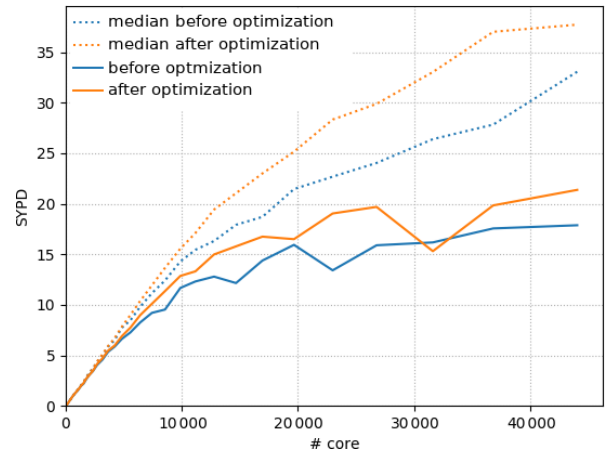
Figure 9. Computing time (in seconds) per time step for a West Atlantic simulation run with 2049 cores. The grey (orange) dashed line shows the mean (median) computing time of one time step.